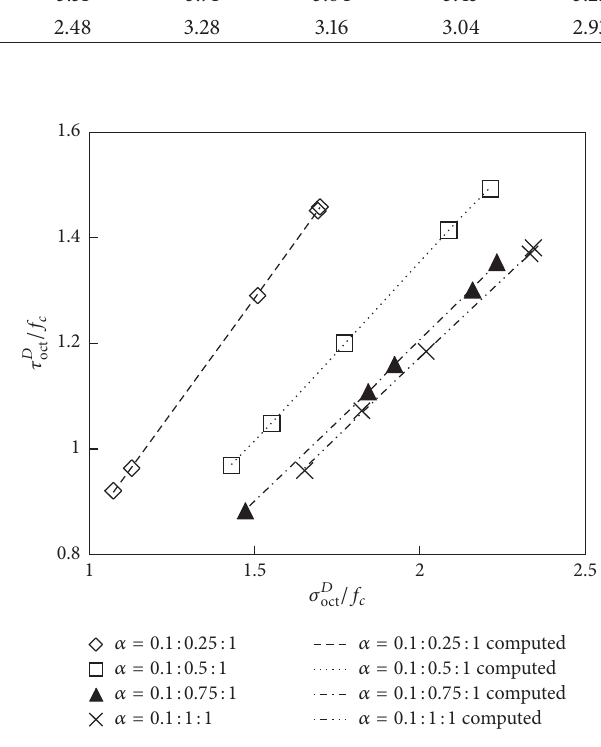
Figure 4: Test results of triaxial compressive strength after rapid freeze-thaw cycles in octahedral stress